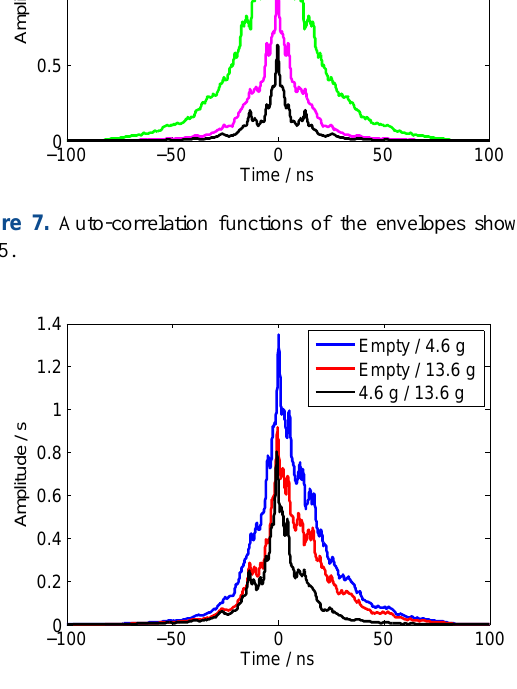
Figure 8. Cross-correlation functions of the envelopes shown in Fig. 5.